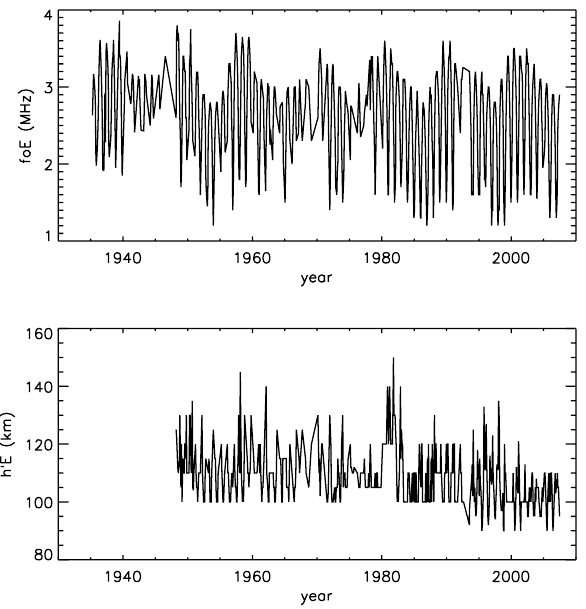
Fig. 2. Scatter plots of f oE (upper panel) and h 0 E (lower panel) versus sunspot number (SNN). Solid red lines show the minimized absolute deviation linear fits, red dashed lines the extremes derived from standard deviations in gradients and intercepts of the fit, and the orange lines show the extents of the mean standard deviation of the individual absolute deviations. There is a 15% uncertainty in the gradient of the linear regression of f oE on SNN and a 23% uncertainty for h 0 E